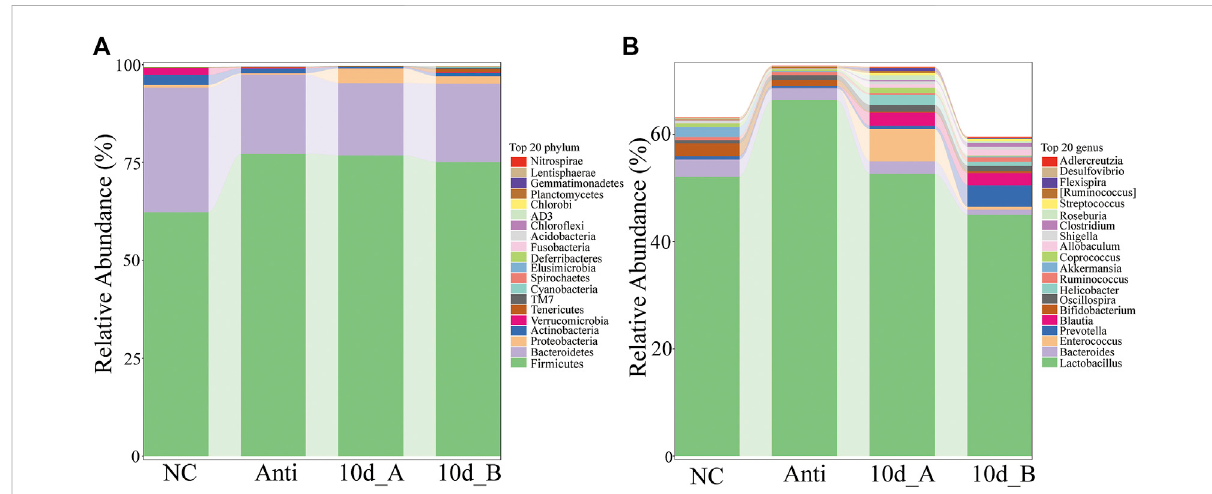
FIGURE 10 Differencesofintestinal fl ora atthelevel of phylum and genus in ratswith bacterial fl ora disorder. (A) Stackingdiagram ofspecies distributionat the phylum level (the normal group: NC; Antibiotic group: Anti; the spontaneous recovery group: 10d_A; XFBD group: 10d_B). (B) Stacking diagram of species distribution at the genus level (the normal group: NC; Antibiotic group: Anti; the spontaneous recovery group: 10d_A; XFBD group: